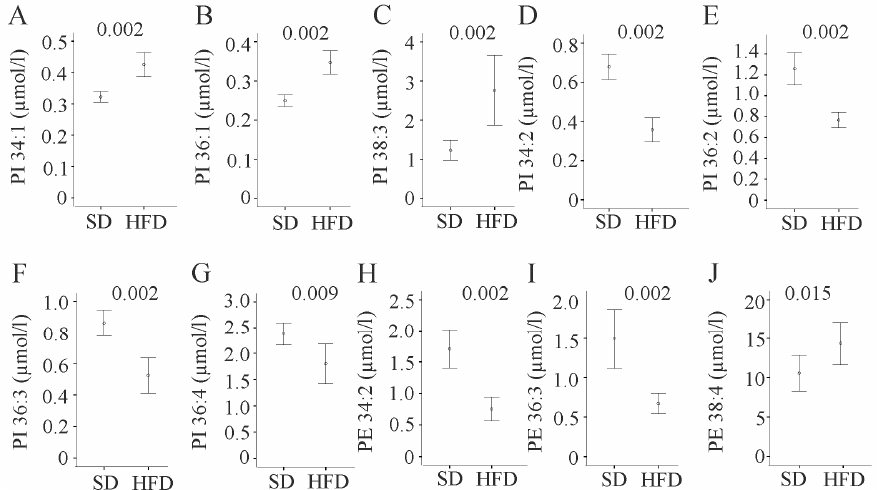
Figure 4 . Correlation of lipid species with systemic cholesterol and fasting glucose ( A ) Correlation of PC 40:2 with cholesterol; ( B ) Correlation of PC 40:5 with